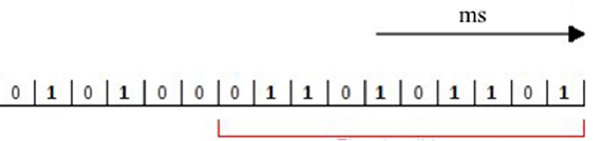
Fig 4. Light window. Each cell represents one millisecond, and the value in the cell represents the number of photons that reach the retina within the same